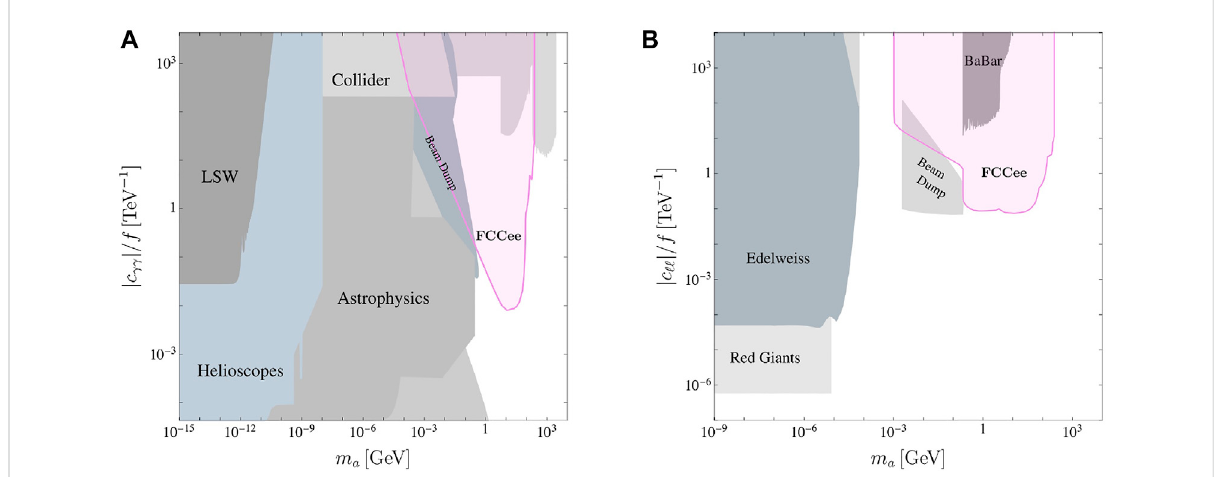
FIGURE 7 Projected sensitivity of FCC-ee in (A) e + e − → γ a → 3 γ and (B) e + e − → γ a → γ ℓ + ℓ − in purple. Figure adapted from Figure [188].